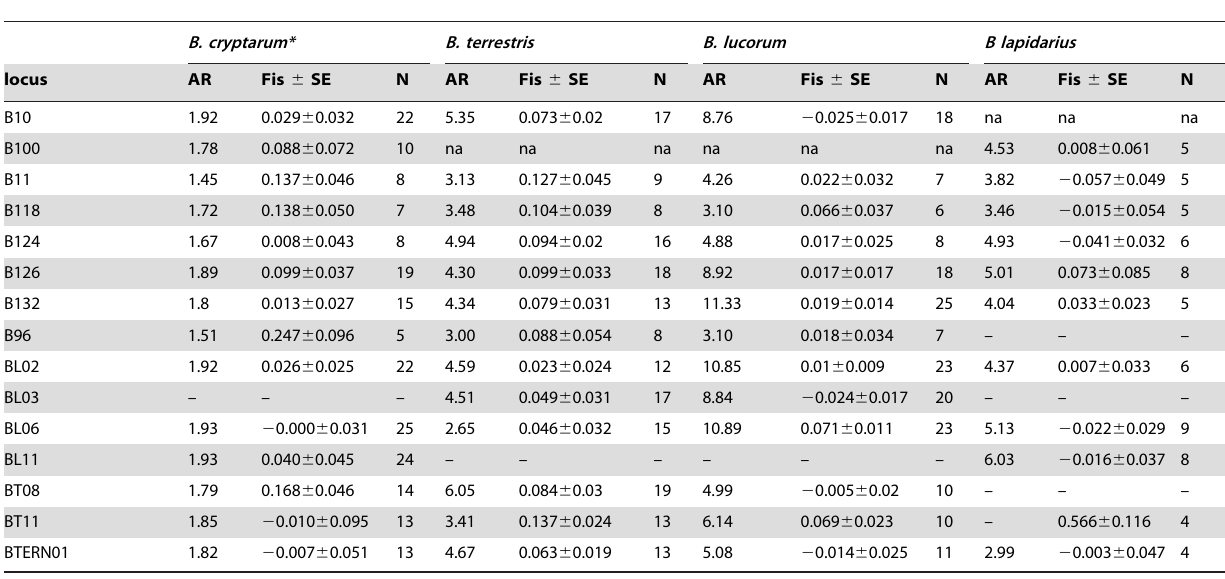
Table 2. Characteristics of the microsatellite loci used in each